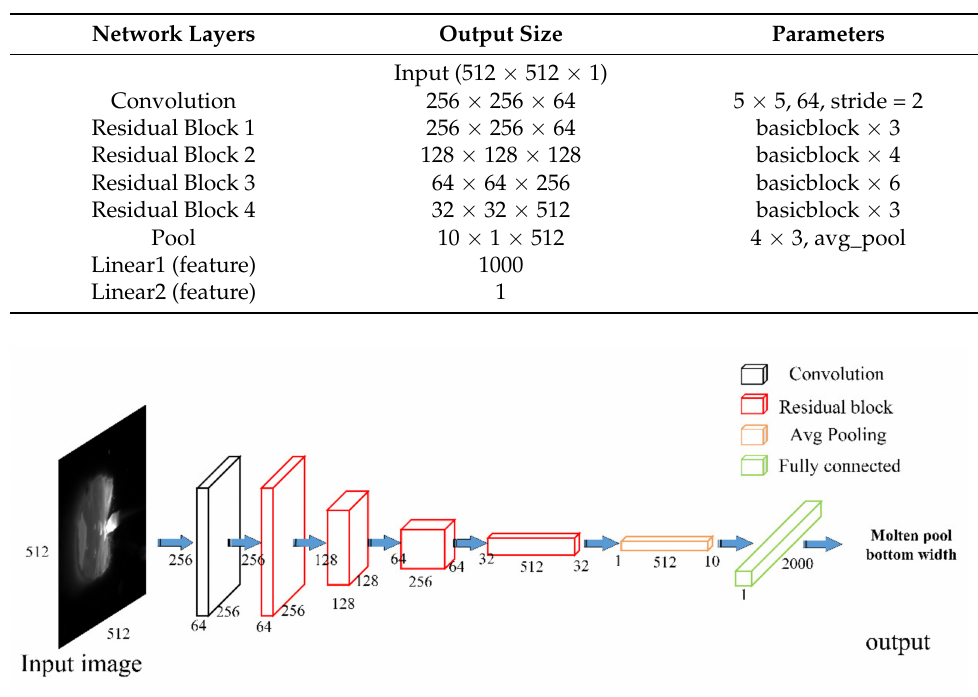
Table 2. Bottom molten pool width prediction network specific information.